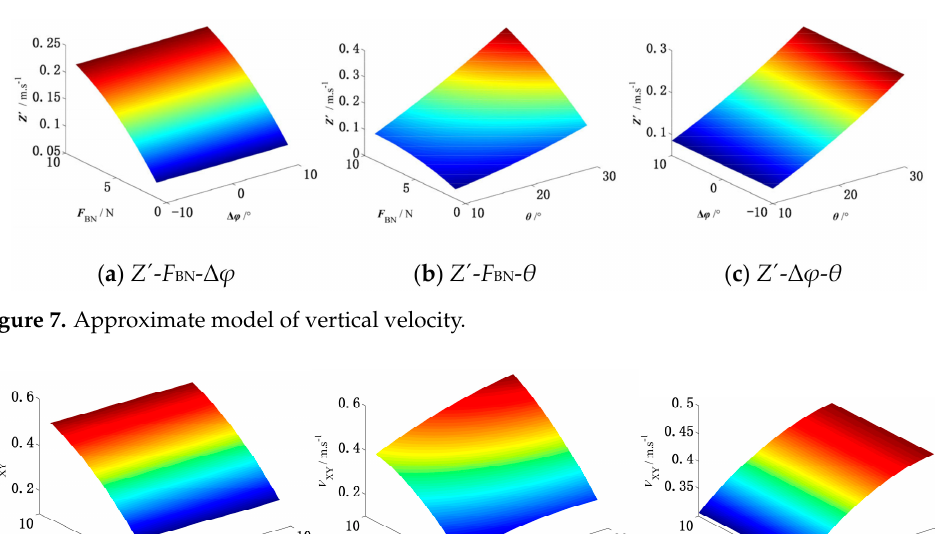
Figure 9. Approximate model of heading angular velocity.